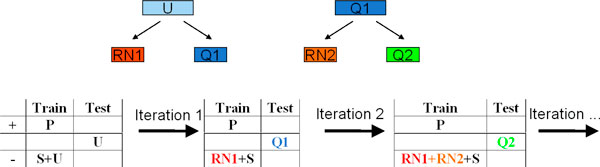
The spy technique.